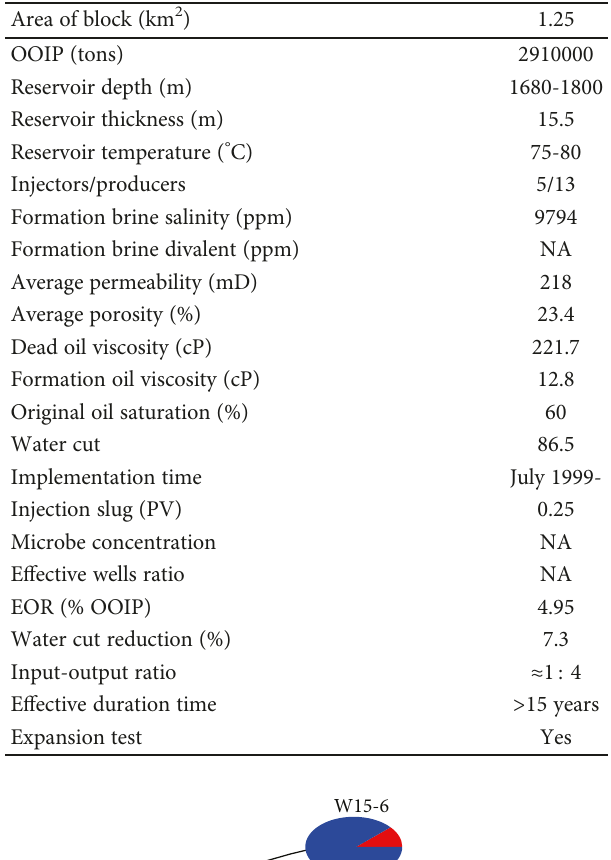
Table 6: Luo 801 block microbial fl ooding fi eld test in Shengli Oil fi eld.